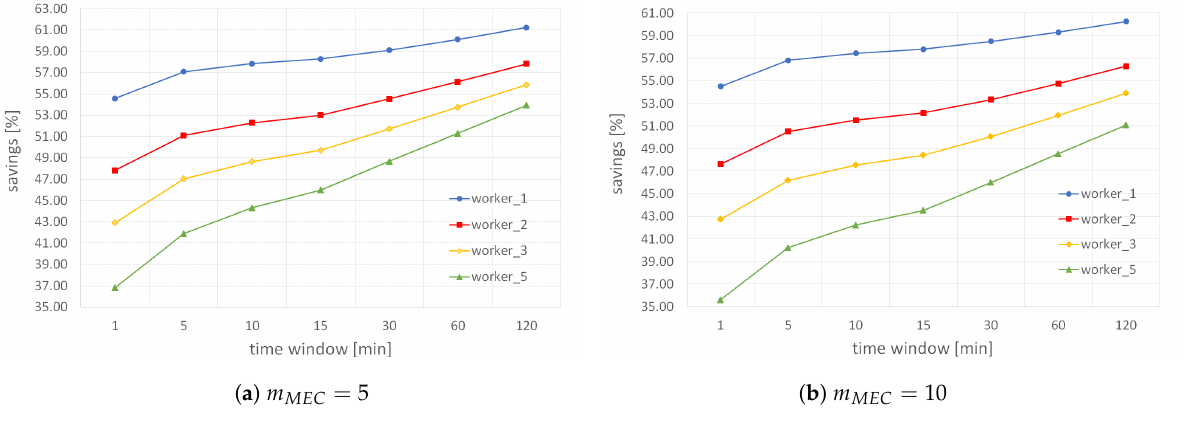
Figure 11. Energy savings with respect to the parameter m MEC